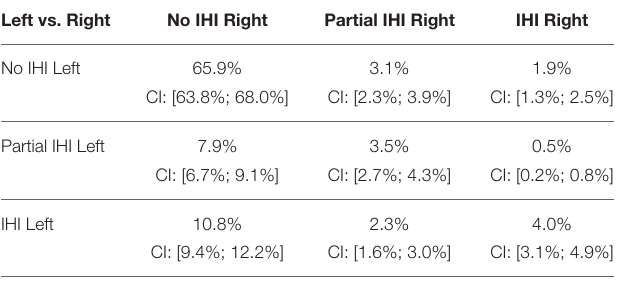
TABLE 7 | Co-occurences (in % of the population) of IHI for the left and right hippocampi, according to the global criterion C0. Left vs. Right